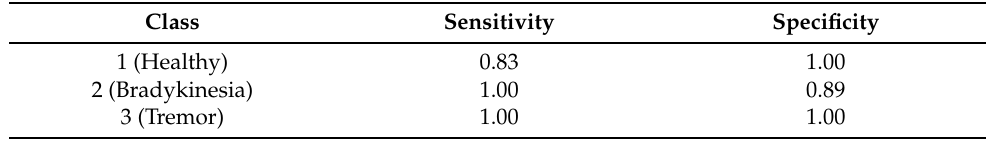
Figure 11. KNN classifier results Figure 12 elaborates the receiver operating curves (ROC) for each class, i.e., healthy, tremor and bradykinesia subjects. ROC curves are helpful in finding out sensitivity and specificity by using TRP and FPR. Figure 12a shows the ROC of the healthy participants, where TPR is 0.83 and FNR is 0.0. Figure 12b shows the ROC of the bradykinesia class, where TPR is 1.0 and FPR is 0.11 and Figure 12c presents ROC of the tremor class, where TPR is 1.0 and FPR 0.0. Table 5 describes the sensitivity and specificity of each class. Table 5. Sensitivity and specificity of each